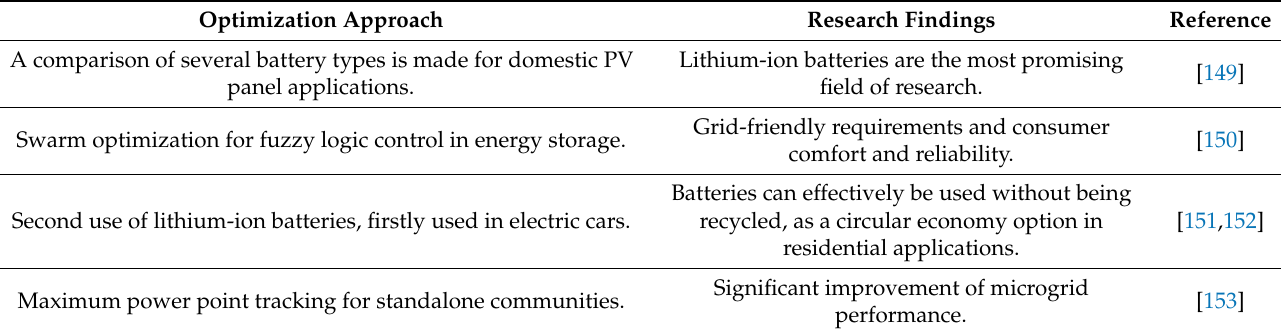
Table 8. State-of-the-art of the optimization methods and research findings based on energy storage systems in standalone